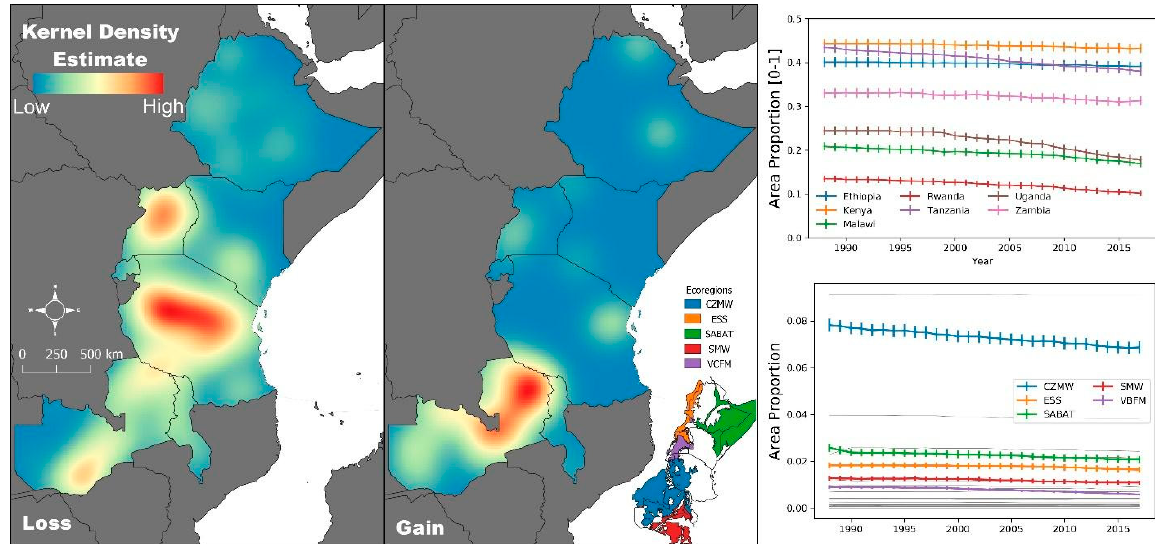
Figure 10. Heatmaps of loss and gain of Wooded Grassland. Left: Kernel Density hotpot analysis of loss and gain of Wooded Grasslands. Top: Proportional change of Wooded Grasslands in seven countries. Bottom: Proportional change of Wooded Grasslands in ecoregions in which the five ecoregions with the greatest change are colored (CZMW, Central Zambezian Miombo Woodlands, SMW, Southern miombo woodlands, ESS, East Sudanian savanna, VBFM, Victorian Basin forest-savanna mosaic, SABAT, Southern Acacia-Commiphora Bushlands and Thicklets). The grey lines represent the other ecoregions.